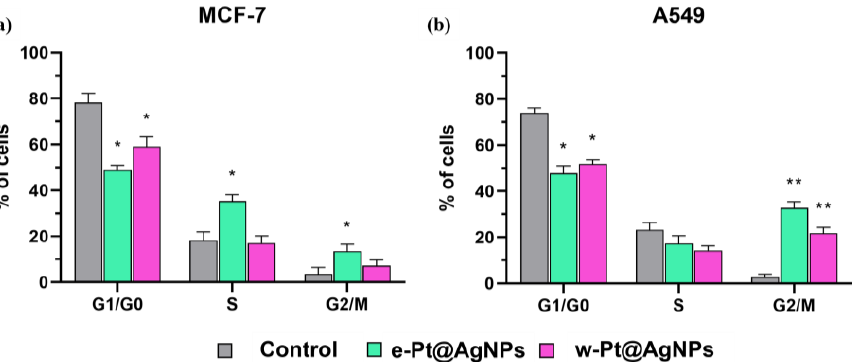
Figure 9. Cell cycle distribution plots of e -Pt@AgNPs and w -Pt@AgNPs after treatment on ( a ) MCF-7 and ( b ) A549 cancer cells at 24 h. Untreated cells are denoted as control. Data represented as mean ± SD from three independent experiments with differences * p < 0.05 and ** p < 0.01 considered significant.